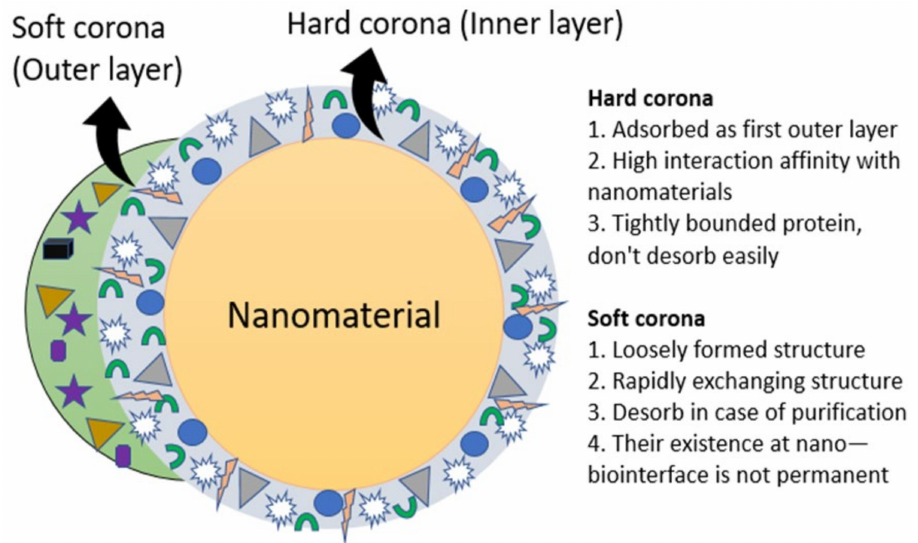
Figure 2. A hard versus soft protein corona model on the surface of nanomaterials in the biological milieu. Hard corona is analytically accessible by the NP–protein complex which is adsorbed primarily when NPs are in contact with a biological medium. It is tightly bound due to a high degree of affinity and isdesorbed easily. In contrast, soft corona is loosely bound and rapidly exchangesbiomolecules. The term protein corona/biomolecule corona is exchangeable with hard corona or analytically accessible